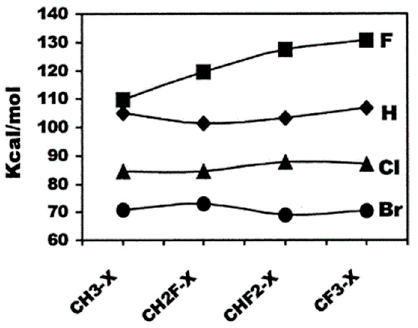
Figure 4. C-X bond energies in the model molecules CH 3 -X, CH 2 F-X, CHF 2 -X, and CF 3 -X, with X = H, F, Cl, and Br (reprinted from [25]).